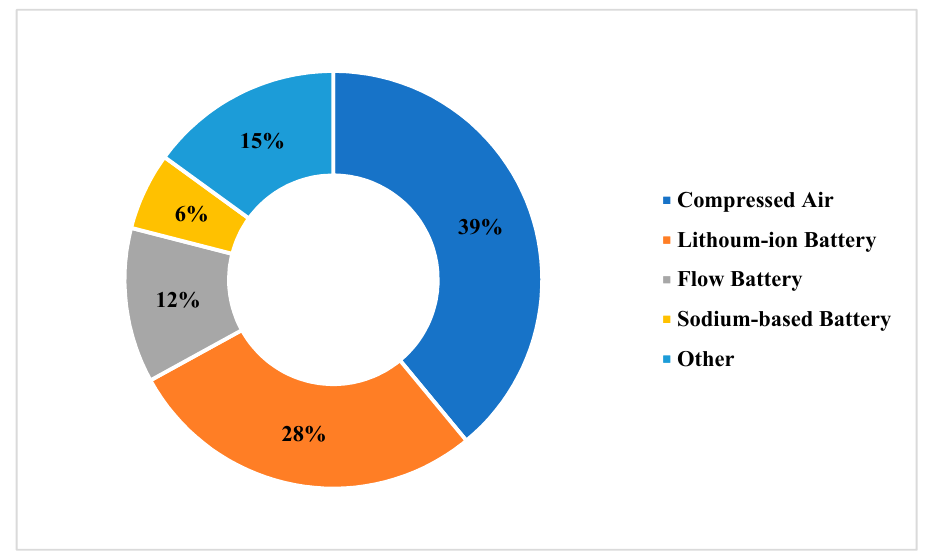
Figure 1. Distribution of non-Pumped Storage Hydropower (PSH) storage volume (totaled 15,300 MWh in 2017). Figure was reproduced with data from [2].